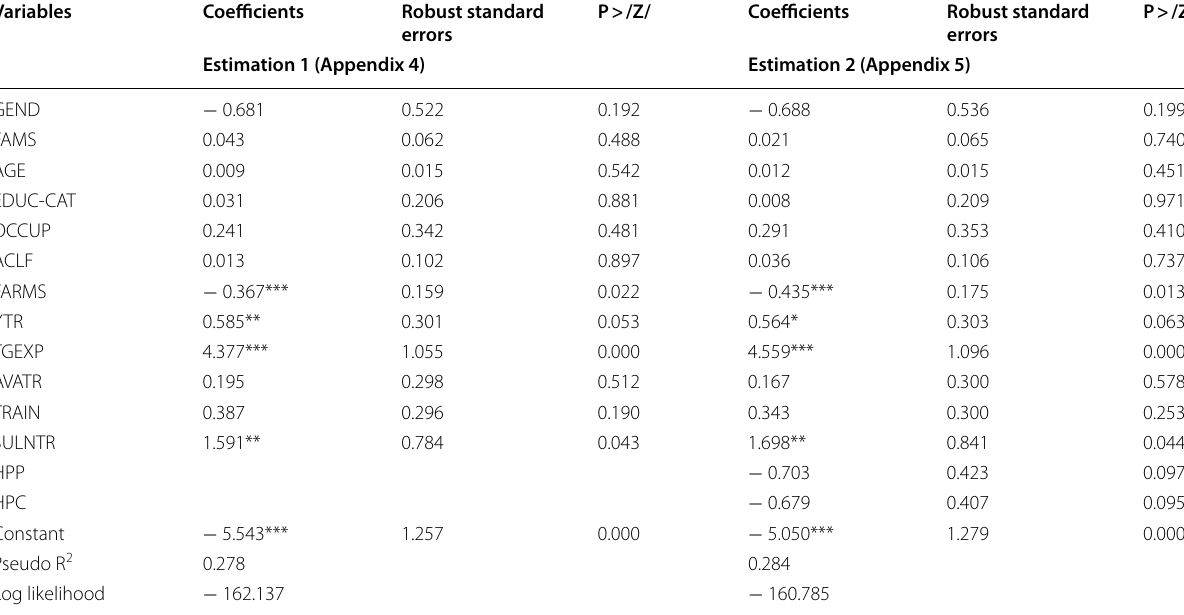
Table 4 Summary of the factors associated with OFATR adoption: The logit